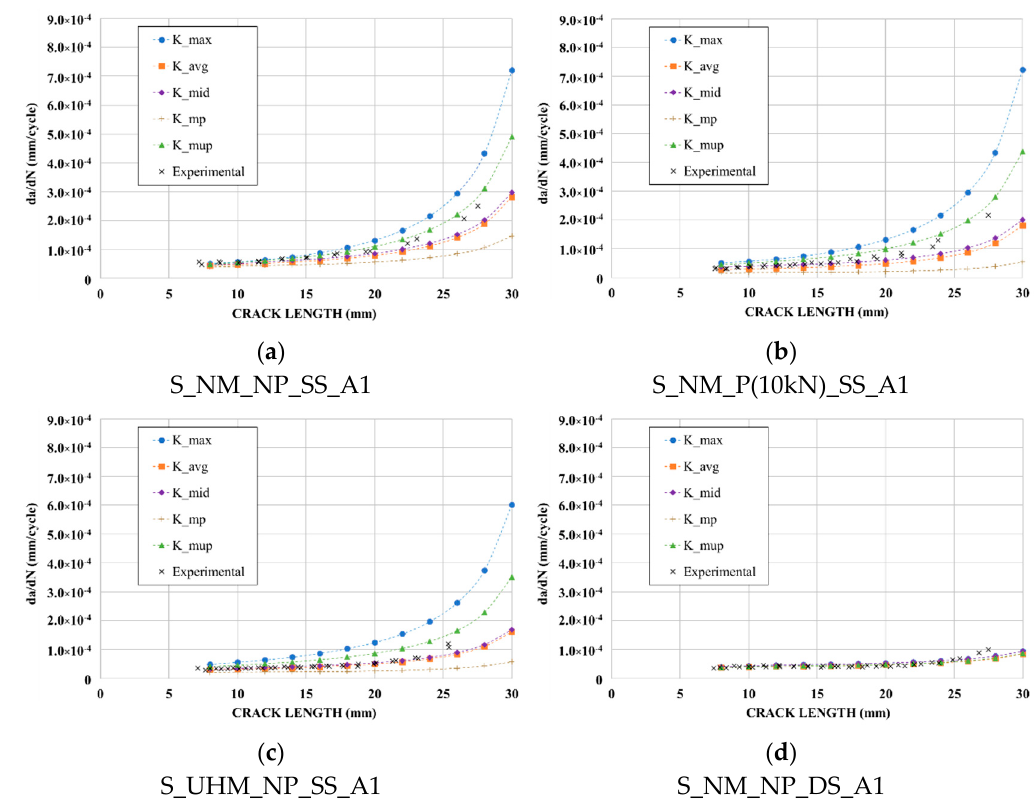
Figure 12. Comparison between experimental and predicted crack growth curves using averaged FEM results: ( a ) Normal Modulus-non-pre-stressed single-sided reinforced specimen; ( b ) Normal Modulus-pre-stressed single-sided reinforced specimen; ( c ) Ultra High Modulus-non-pre-stressed single-sided reinforced specimen; ( d ) Normal Modulus-non-pre-stressed double-sided reinforced specimen.